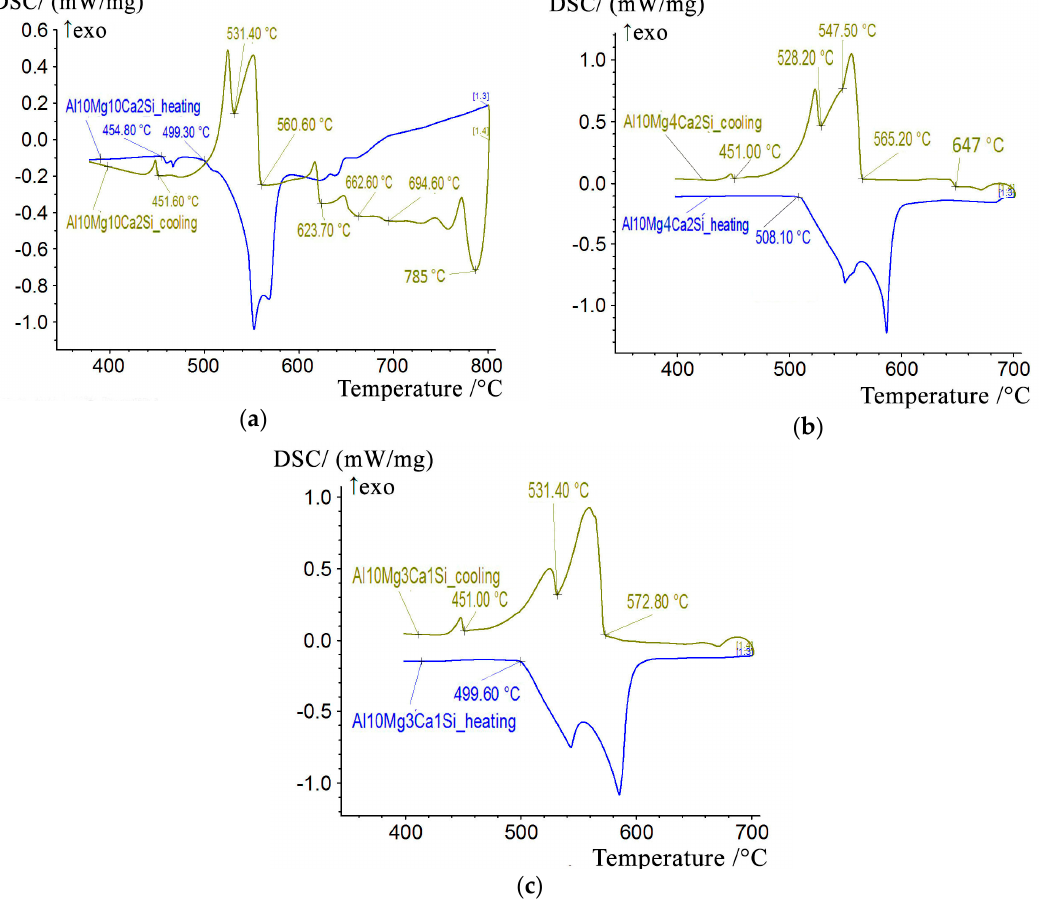
Figure 10. DSC heating and cooling curves for the quaternary alloys: ( a ) Al10Mg10Ca2Si ( b ) Al10Mg4Ca2Si ( c ) Al10Mg3Ca1Si.